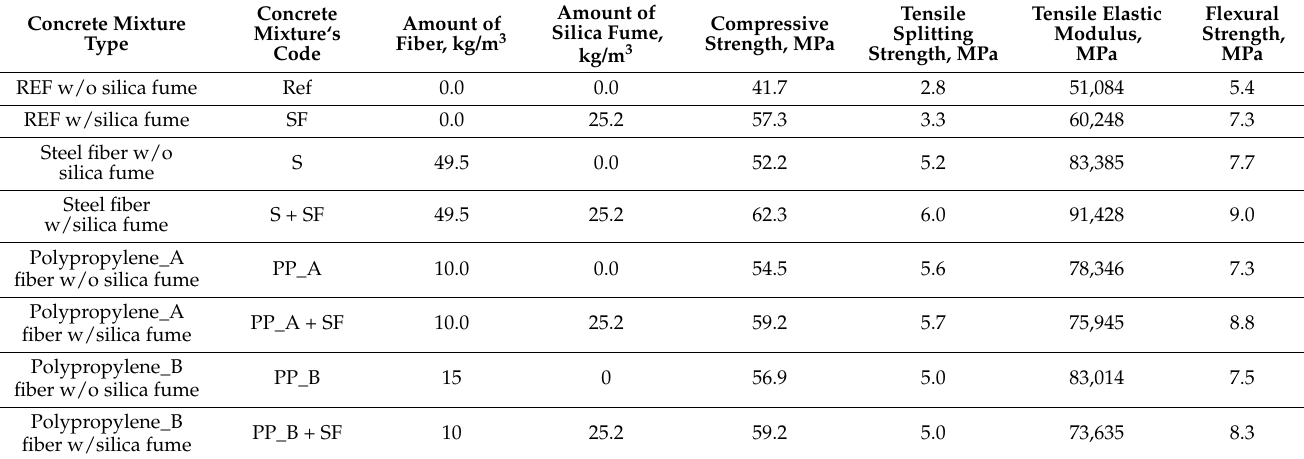
Table 1. Design mechanical characteristics of concrete used in the calculation.